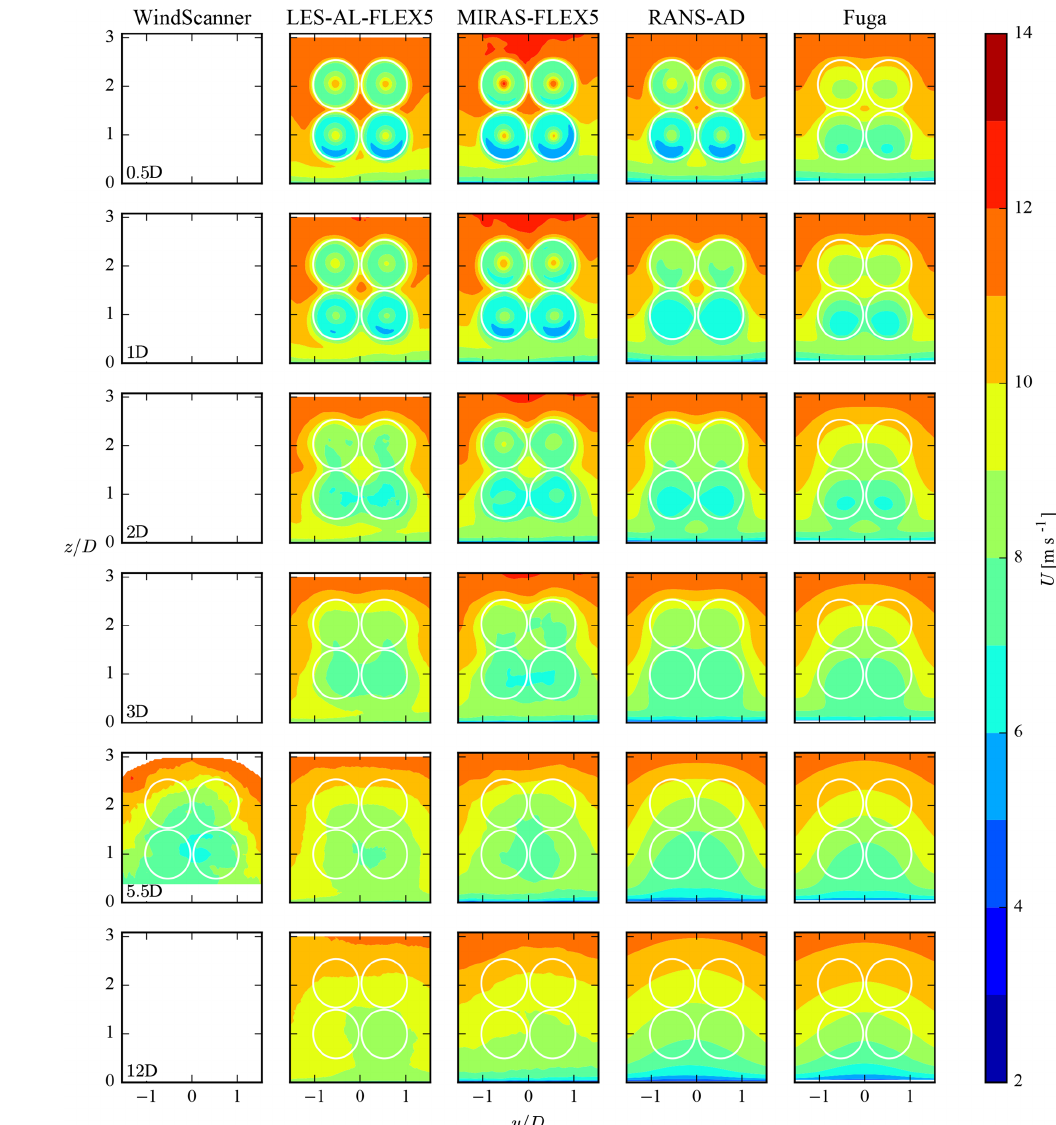
Figure 15. Far-wake case: contours of stream-wise velocity at three downstream